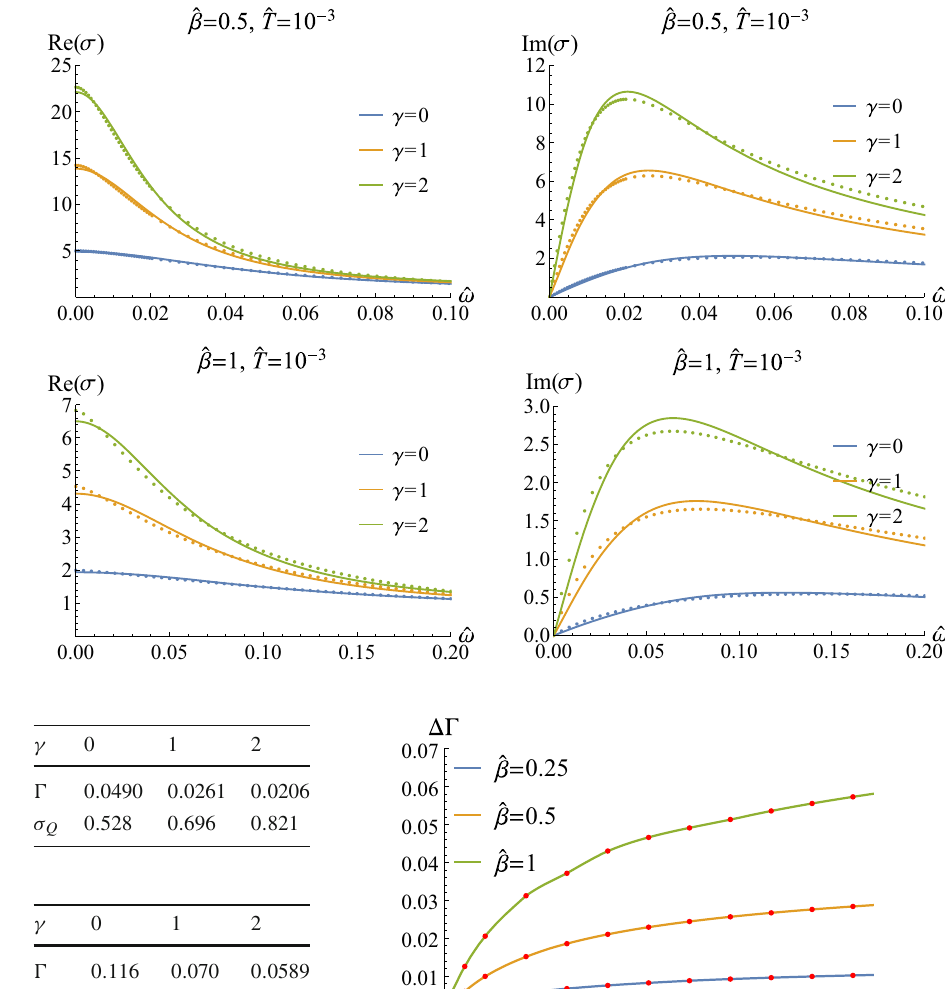
relaxation rate (cid:18) fitted by the modified Drude formula (39) for different γ with fixed ˆ β = 1